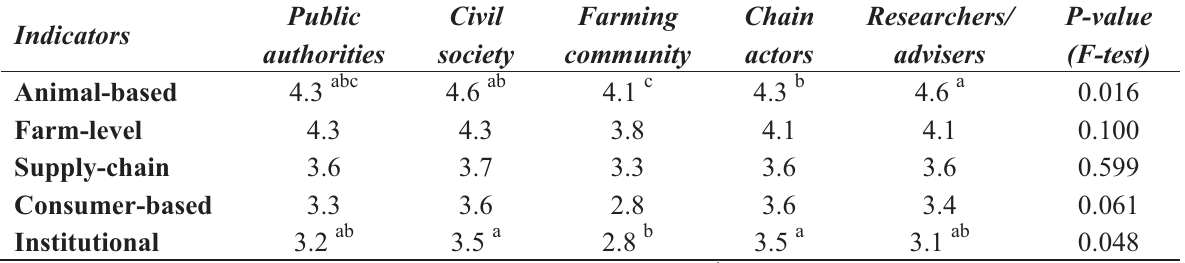
Table 5. Rating (1 to 5 scale 1 ) of the effectiveness of broad categories of indicators according to the different Expert groups (means) (source: [71]).